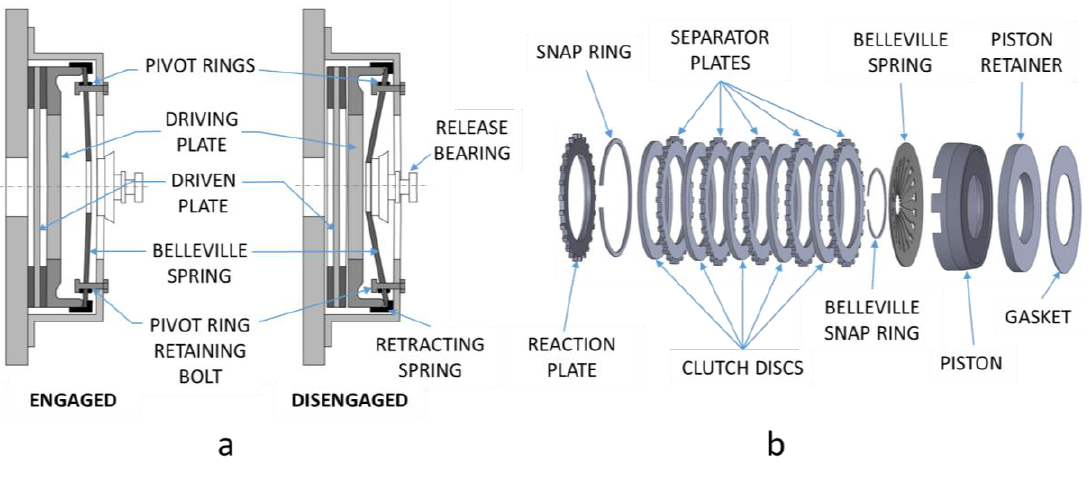
Figure 3. Parts of a transmission clutch with Belleville (diaphragm) spring and its functioning. ( a ) Single; ( b ) 5 clutch discs version.